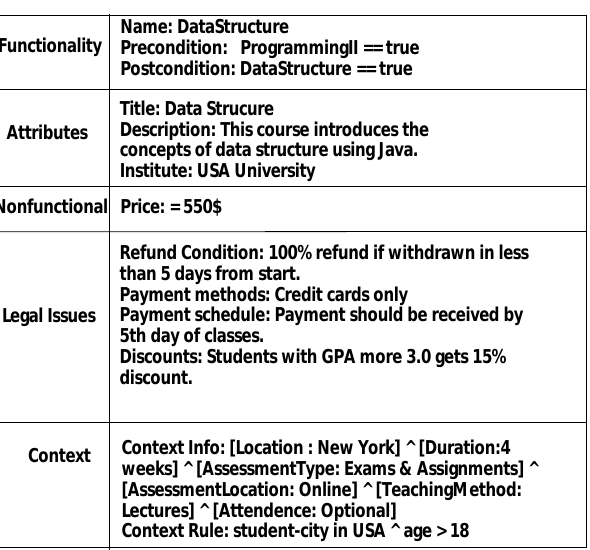
Figure 7. DataStructure ExtendedService The formal representation of the DataStructure Extended- Service is presented below: